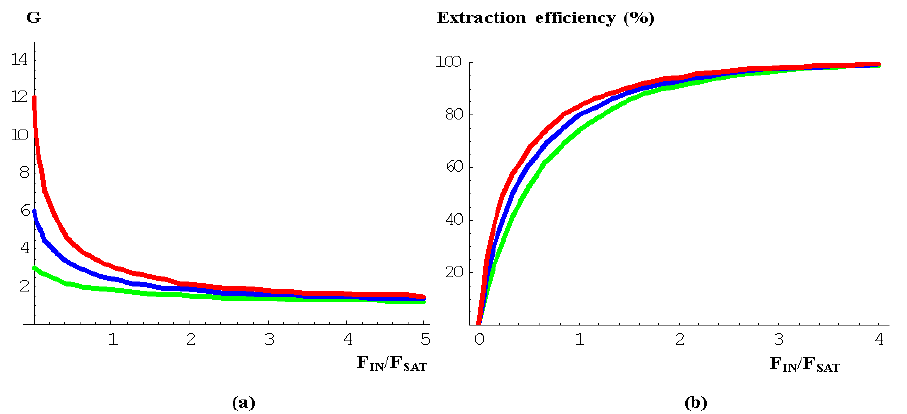
Figure 3. The gain and energy extraction efficiency in laser pulse amplifiers. ( a ) Gain dependence on the ratio between input fluence and saturation fluence, for different small signal gain factors. ( b ) Extraction efficiency versus ratio between input fluence and saturation fluence, for different small signal gain factors. Red line, small signal gain G 0 = 12. Blue line, G 0 = 6. Green line, G 0 = 3.